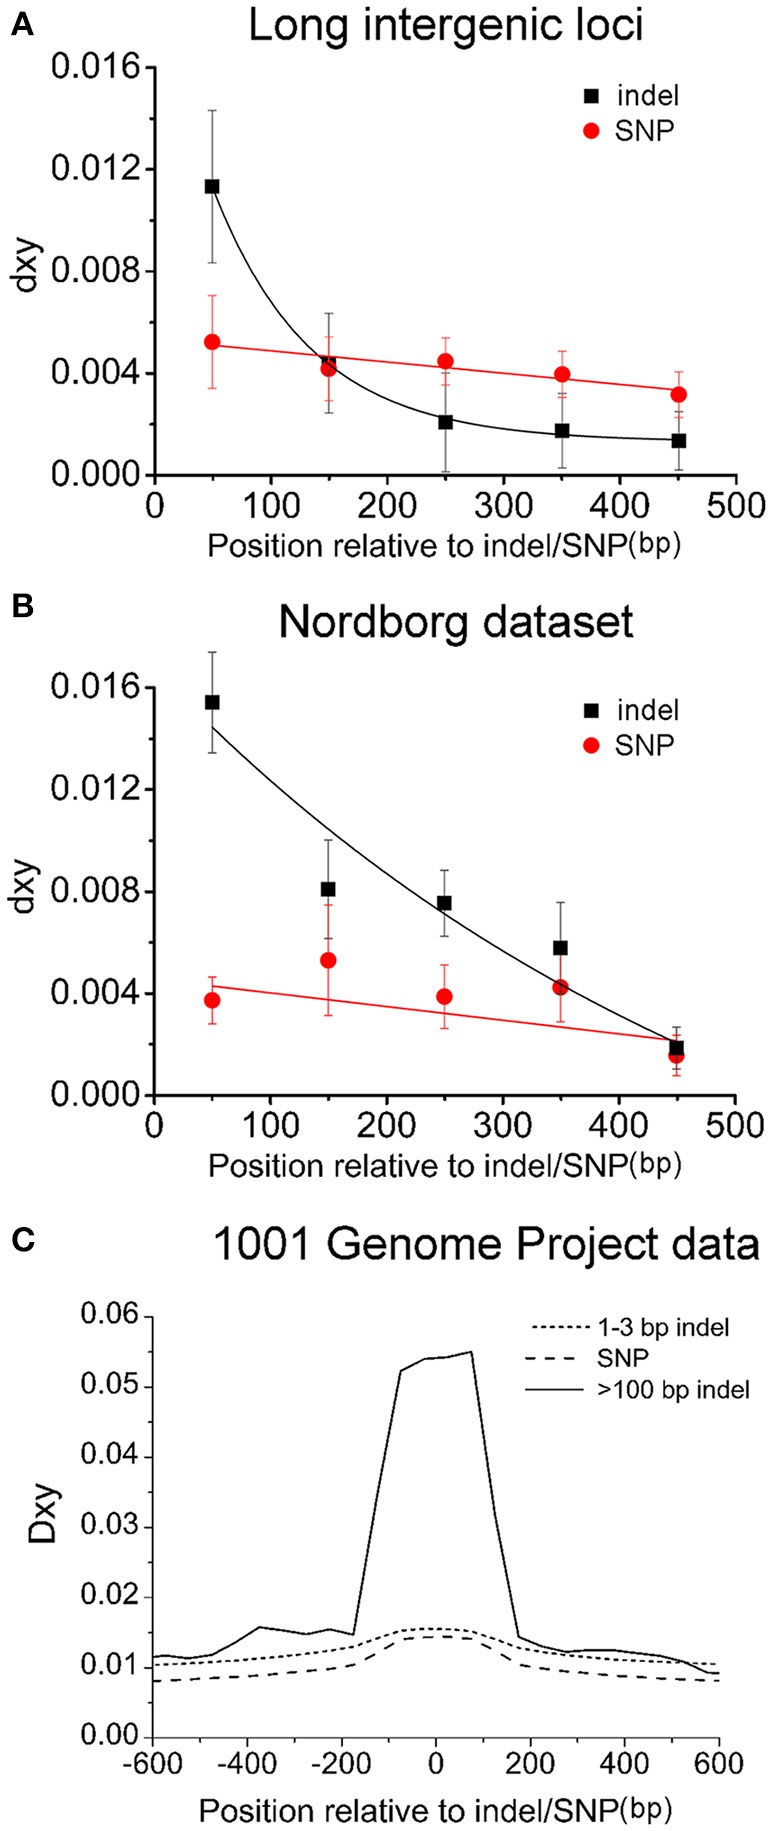
Indel-centered distribution of nucleotide substitutions around indels in long intergenic regions (A), the Nordborg dataset (B) and the 1001 genome project (C). In A, the balck-filled squares represent 103 indels within 39 different-colored (dimorphic) patterns and the red-filled circles stand for the sampled 39 SNPs, each of which is located at the closest position to the center point of a dimorphic pattern. (B) Relationship between distance from the first encountered indel or SNP at a locus and the corresponding dxy in the Nordborg data. The standard error of mean (SEM) was denoted as error bar for each point. (C) Nucleotide polymorphism between insertion-present and –absent accessions around large indels (>100 bp), small indels (1–3 bp), and SNPs sampled from the genomic sequences of the 81 accessions produced by the 1001 Genome Project.